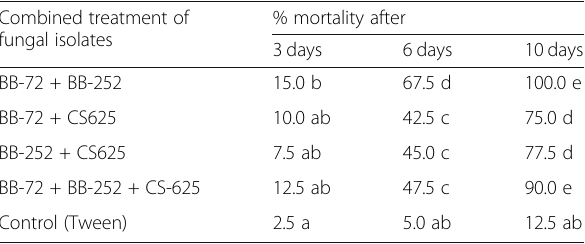
Table 3 Effect of combined treatments on the mortality of green peach aphid Combined treatment of fungal